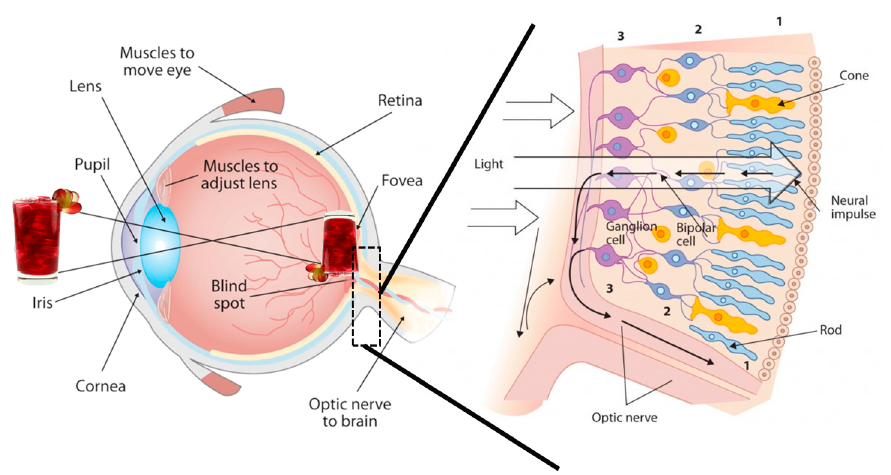
Figure 2. Anatomy of the human eye and the retina with its specialized cells. (1) Light entering the eye triggers the photochemical reaction in rods and cones of the retina; (2) chemical reaction activates bipolar cells; (3) information is sent to the visual cortex via the thalamus. Retrieved and adapted from Stangor and Walinga [8].